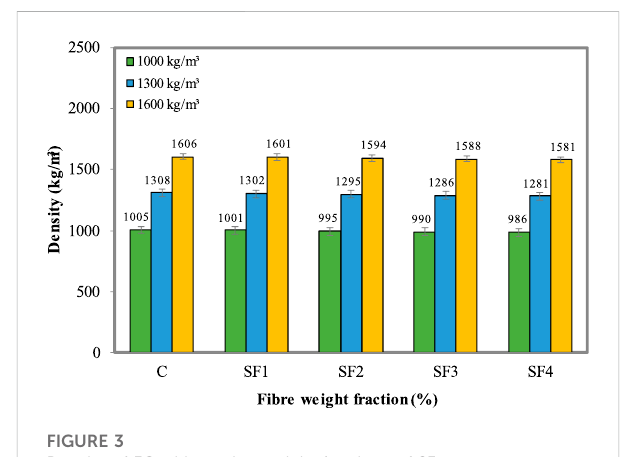
FIGURE 3 Density of FC with varying weight fractions of